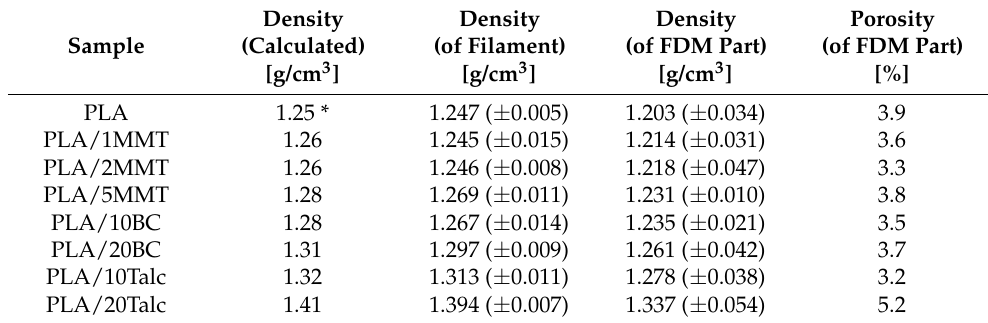
Table 2. The results of density/porosity calculations and measurements.